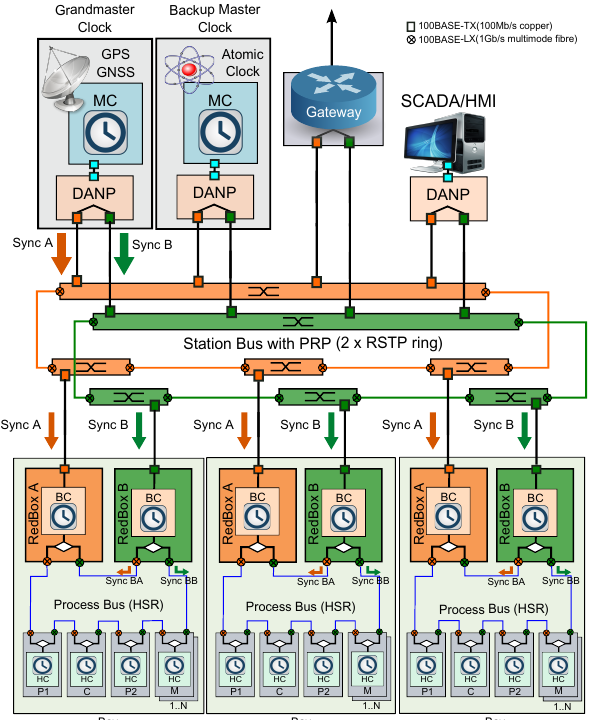
Figure 3. Station and process bus with redundancy and synchronization